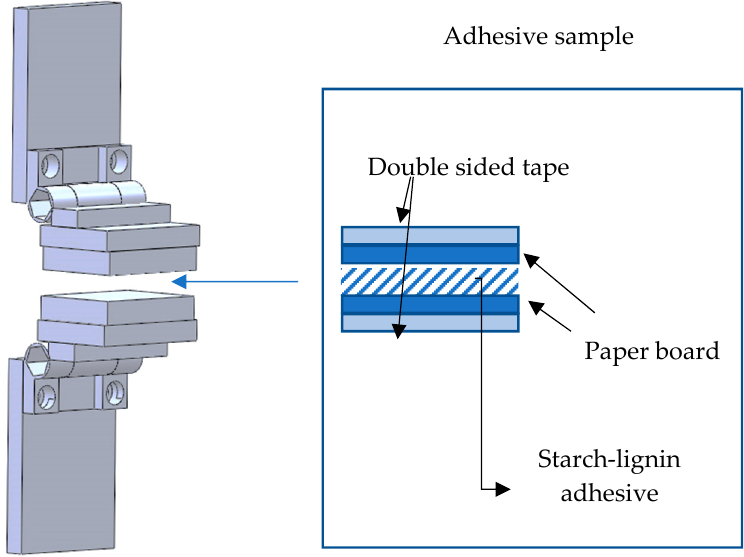
Figure 4. Hinges and an adhesive sample used for assessment of the glued joints with starch-based adhesives.